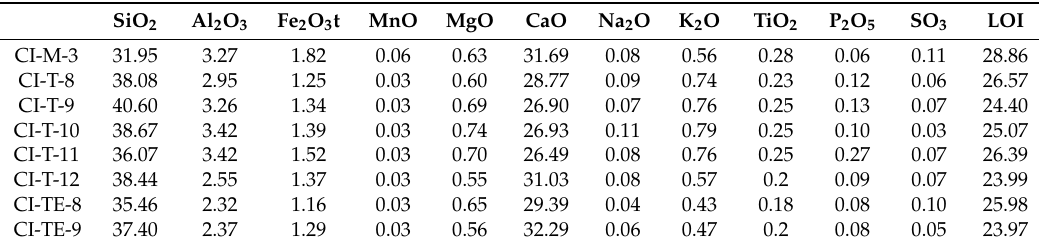
Table 3. Result of chemical composition of major elements of bulk mortar determined by X-ray fluorescence expressed as oxides in wt %. The iron content has been expressed as total Fe 2 O 3 t. LOI: loss on ignition